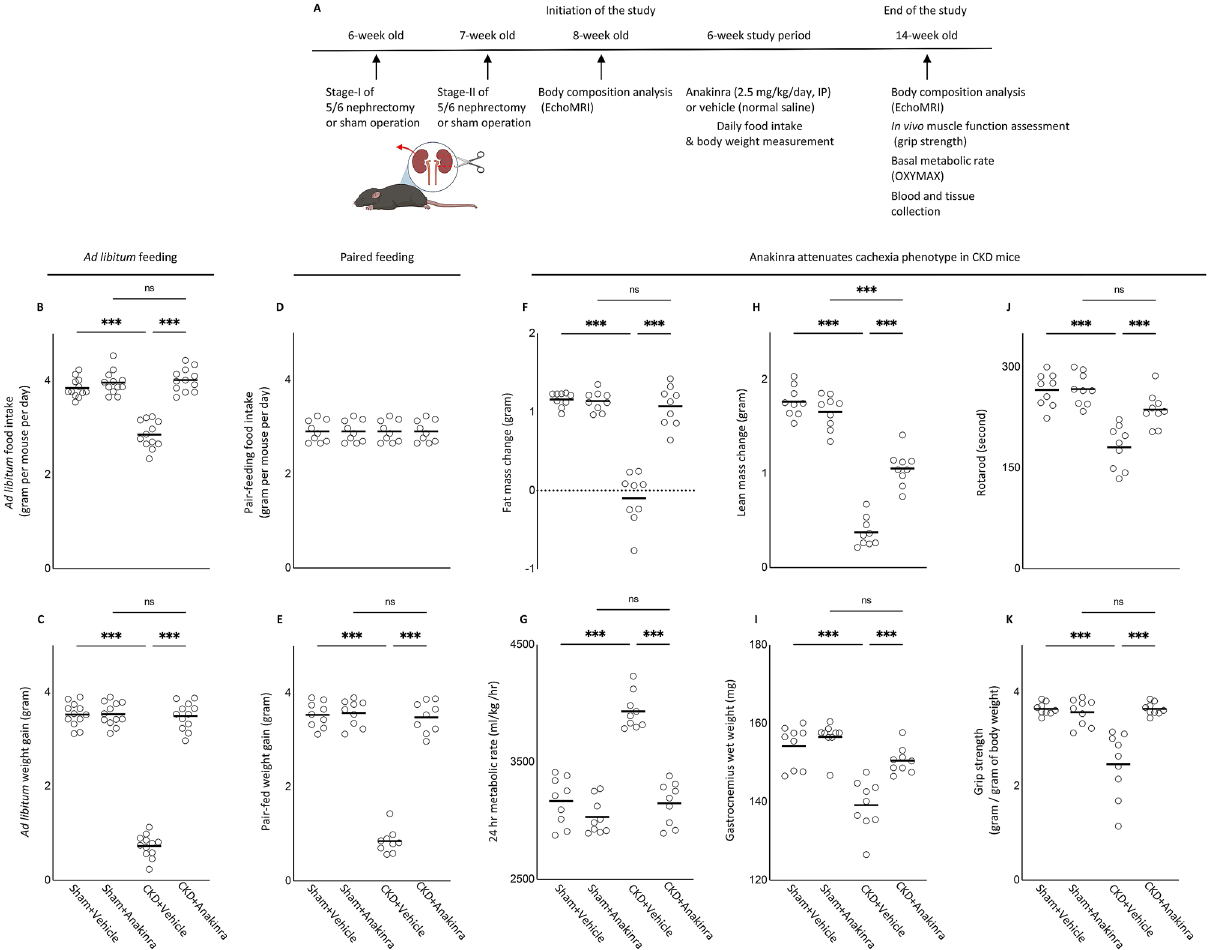
Figure 2. Anakinra attenuates cachexia in CKD mice. WT/CKD and WT/Sham mice were treated with anakinra (2.5 mg/kg/day, IP, daily) or normal saline as a vehicle control for 6 weeks. Schematic experimental design is shown ( A ). Figure 2A was created with BioRender.com. Results Mice were fed ad libitum and food intake and weight gain in mice were recorded ( B , C ). To assess the beneficial effects of anakinra beyond its nutritional effects, we employed a pair-feeding strategy. WT/CKD mice treated with vehicle were given an ad libitum amount of food whereas other groups of mice were given an equivalent amount of food ( D ). Weight change, fat and lean mass content, 24-h oxygen consumption and in vivo muscle function (grip strength) was measured in mice ( E – K ). Data are expressed as mean ± SEM. Results of WT/CKD + Vehicle were compared to WT/Sham + Vehicle and WT/CKD + Anakinra were compared to WT/Sham + Anakinra, respectively. In addition, results of WT/CKD + Anakinra were also compared to WT/CKD + Vehicle. * p < 0.05, ** p < 0.01, *** p <